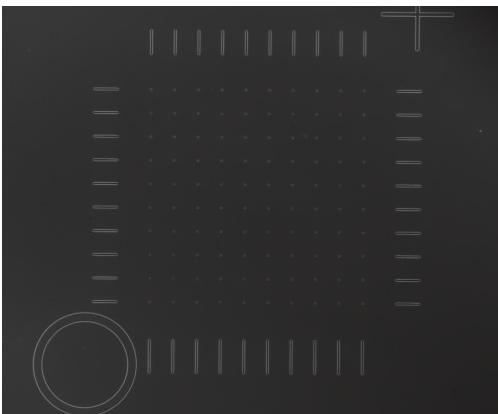
Figure 1: SEM image of the patterned silicon substrate used for the vertical deposition process. The pattern includes one hundred circular pores, 200 nm in diameter, in a square array surrounded by twenty alignment markers identifying the locations of the columns and rows, and auxiliary identification marks (ring and cross). The spacing between adjacent rows and columns is 5 μ